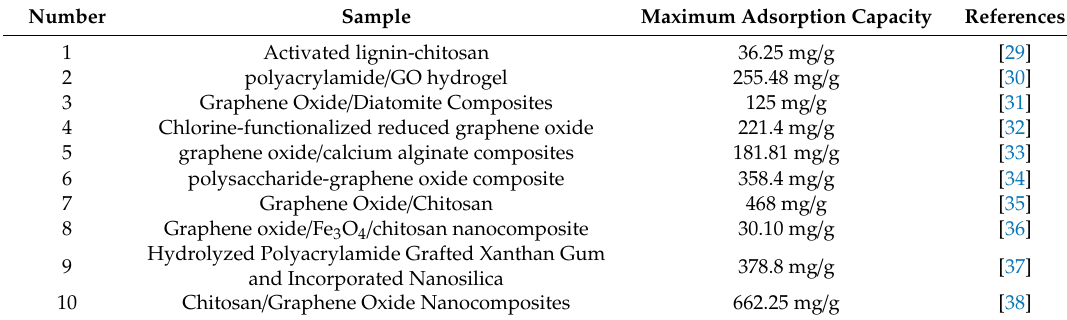
Table 3. The maximum adsorption capacity of MB by various materials.